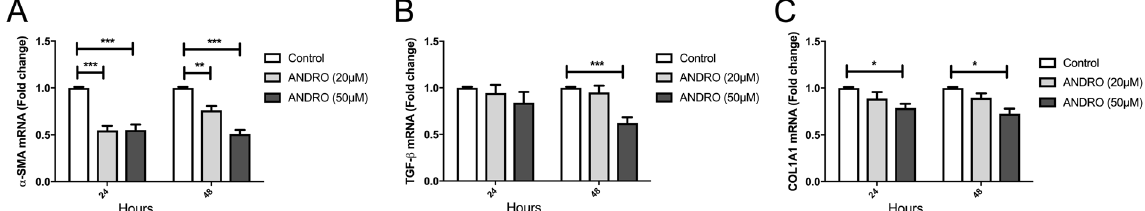
Figure 10. Andrographolide (ANDRO) modulates expression of fibrogenic genes in HSC. HSCs were isolated from male Wistar rats as described in material and methods section. Cells were incubated at different time points (24 and 48 hours) with two different AP concentrations (20 and 50 μ M). Then, mRNA expression of relevant hepatic fibrogenic genes [Alpha-smooth muscle actin ( α -SMA), transforming growth factor beta (TGF- β ) and collagen type I, alpha 1 chain (COL1A1)] was assessed. The statistical significance was evaluated using ANOVA with a post-hoc Bonferroni multiple-comparison test ( * p ≤ 0.05, ** p ≤ 0.01, *** p ≤